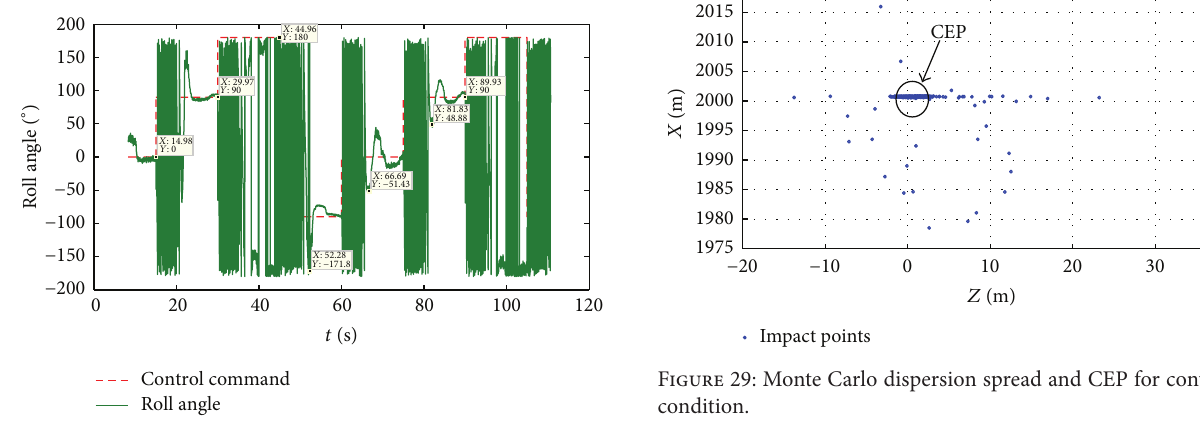
Figure 27: Result of the open loop.